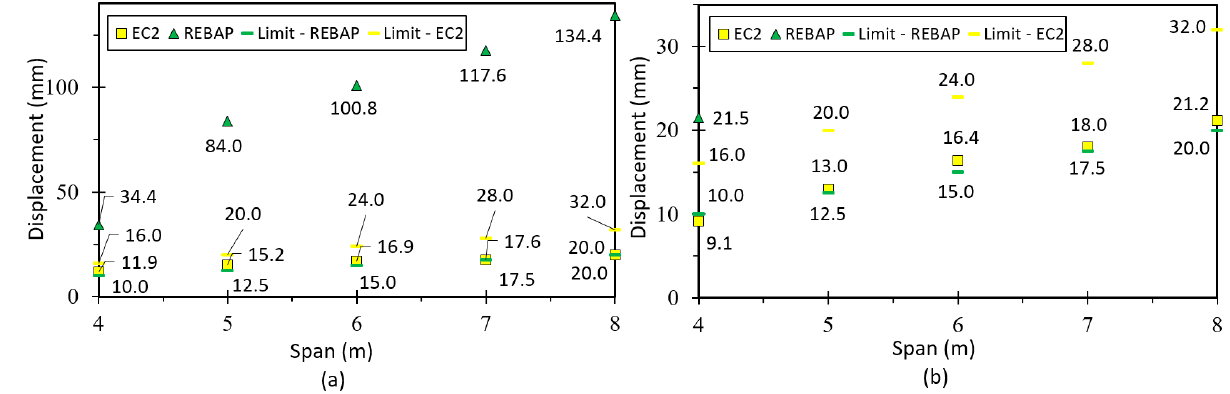
Figure 25. Deformation values of 2NLM: ( a ) analytical and ( b ) numerical, with their limit values, for flat slab.